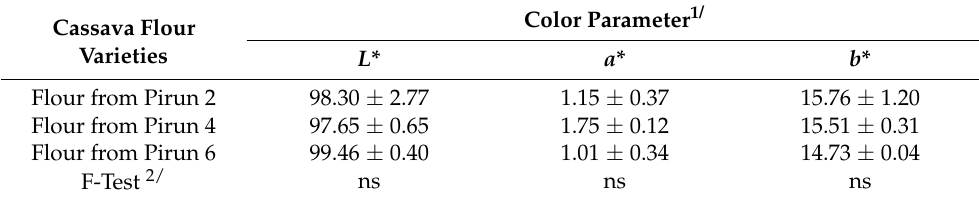
Table 3. Color parameters of flour from three varieties of